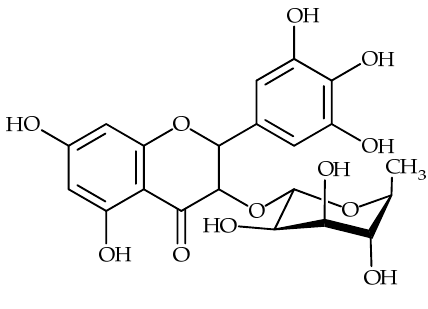
Figure 1. Structure of